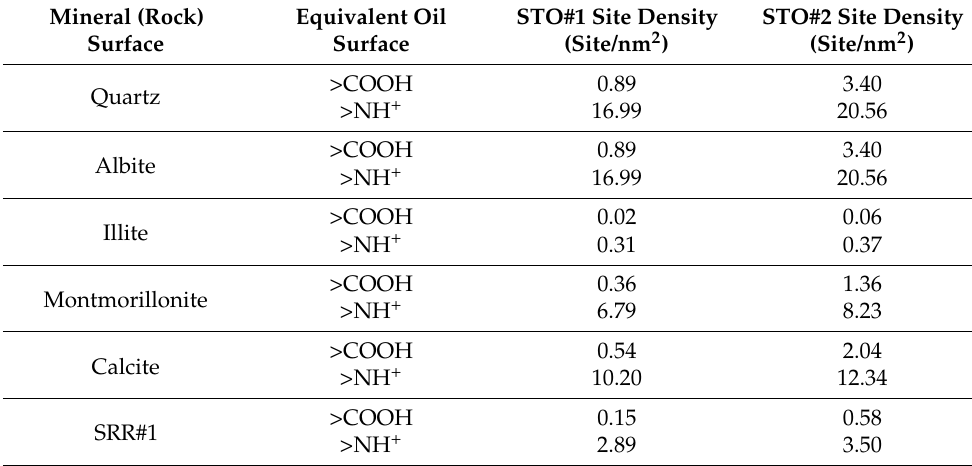
Table 6. Estimated oil site densities of the STO